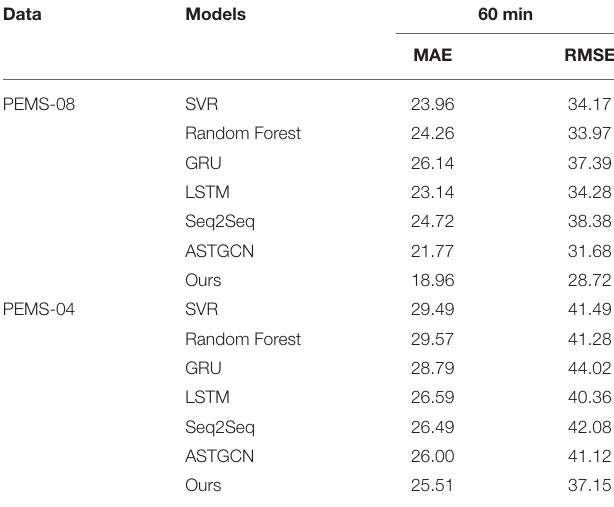
TABLE 2 | Traffic flow forecasting comparison in the next 60min on PeMSD04 and PeMSD08. Data